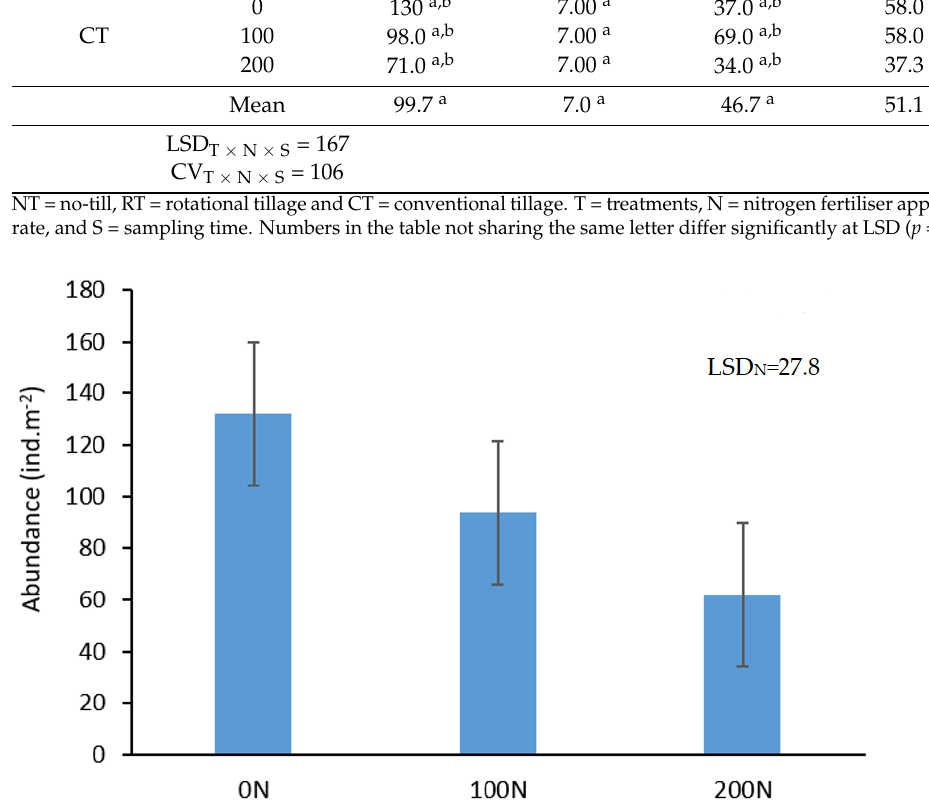
Figure 4. Variation in the abundance of soil macrofauna in three treatments of N fertiliser at different application rates (0, 100 and 200 kg/ha) recorded after 17 years of trial establishment. N = nitrogen fertiliser application rate.